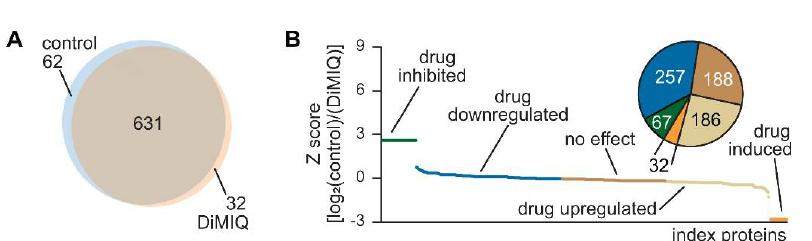
Figure 5. DiMIQ-induced changes in the cellular profile of C. albicans biofilms. ( A ) A set of 725 proteins were identified in the tested fungal biofilms. The control proteome consisted of 693 proteins, whereas the DiMIQ-exposed proteome consisted of 663 proteins. The pool of common proteins contained 631 proteins. ( B ) Only 188 proteins were not affected by the DiMIQ treatment in the cellular proteome of C. albicans biofilms. There was a pool of 218 proteins that were either drug-upregulated or induced, whereas 319 proteins were either downregulated or completely inhibited by the drug.